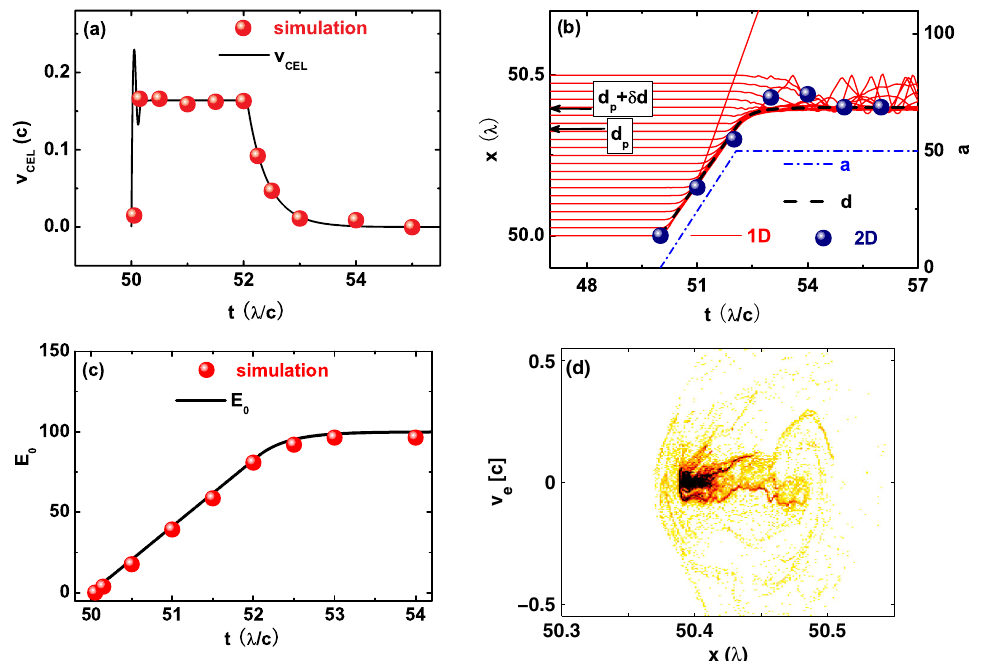
FIG. 2. (a) Velocity of the CEL v CEL from the analytical model (solid line) and average velocity of the CEL from the simulation (solid circle). (b) CEL positions d (dashed line) and incident laser amplitudes on the CEL surface a (dash dotted line) from the analytical model and electron trajectories (solid lines) from 1D simulation and CEL positions (solid circle) from 2D simulation. (c) Maximum charge-separation electric field E 0 from the analytical model (solid line) and simulation (solid circle). (d) Phase-space distribution of electrons at t ¼ 55 T , where T ¼ (cid:3)=c is the laser period and (cid:3) is the laser wavelength. Here n 0 ¼ 40 n c , l 0 ¼ 0 : 5 (cid:3) , and =t ¼ 29 ( a ¼ 50 , t ¼ 1 : 72 T a 0 up 0 up